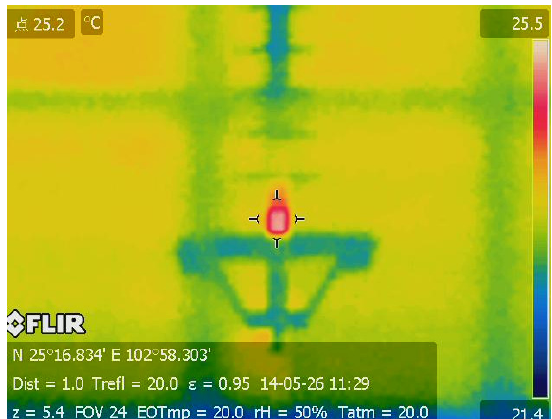
Figure 1. Infrared thermographic inspection of abnormal temperature rises at high-voltage end of onsite composite